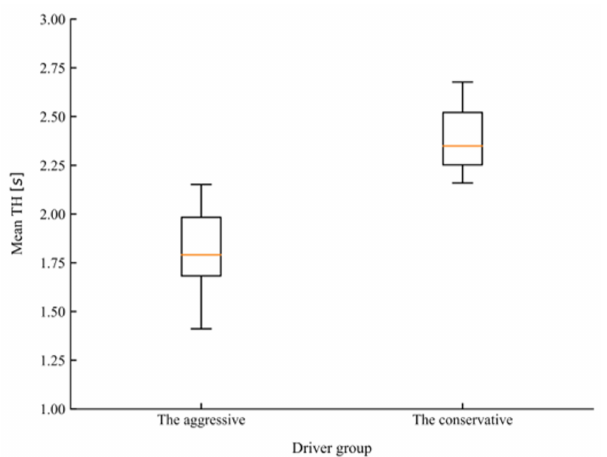
Figure 8. The comparison of mean time headway (TH) for the two driving styles.